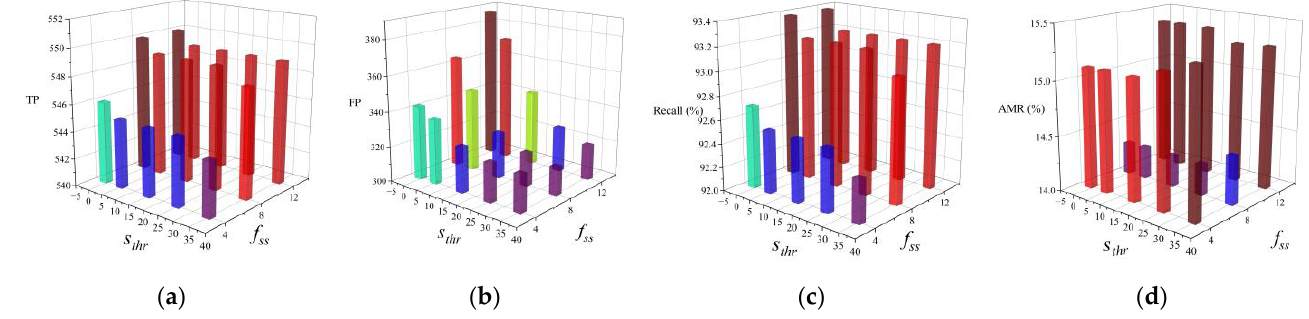
Figure 19. The choices of 𝑠 𝑡ℎ𝑟 and 𝑓 𝑠𝑠 mutually influence the number of true positives ( a ), the number of false positives ( b ), the recall ( c ), and the average miss rate ( d ).